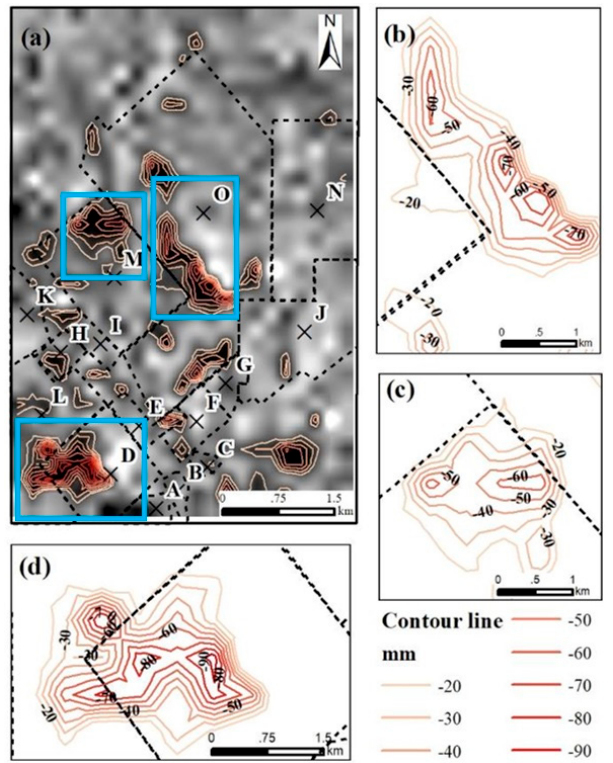
Figure 10. ( a ) Map of the deformation contours obtained from the cumulative displacement from December 2006 to January 2011; ( b – d ) the local deformation contours in the O, M and D coal